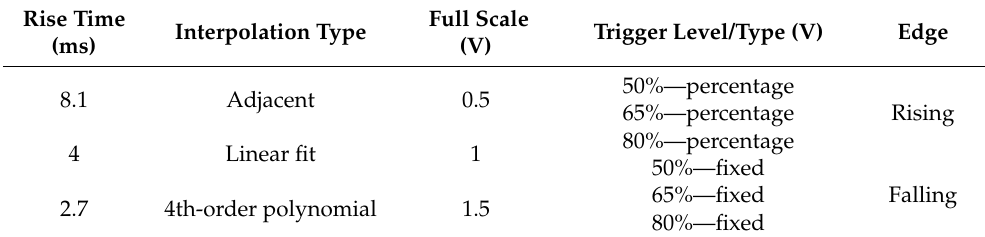
Table 2. Set of parameters used in data processing analysis for a total of 342